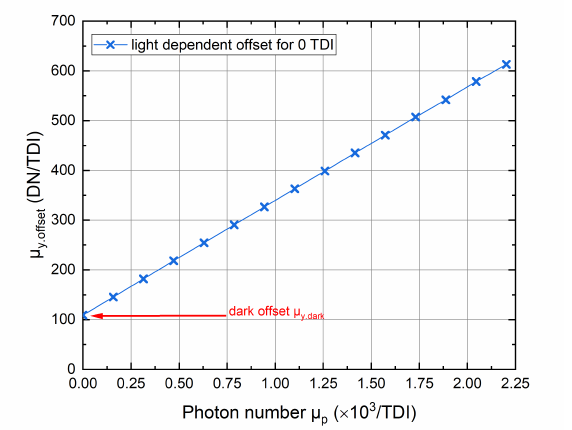
Figure 6. Signal µ y .offset in dependence on the photon number. Red arrow marks the dark offset µ y .dark for E = 0 µW/cm 2